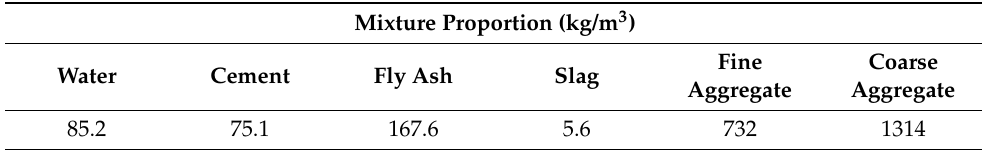
Figure 7. Simplified DuCOM calculation model for dam concrete. According to the DuCOM system and thematerial parameters from the design re- ports, the long-term properties of dam concrete were numerically analyzed. The mineral compositions of the cement, including C3A, C3S, C2S, C4AF, and Gypsum, were 15.50%, 54.76%, 14.16%, 5.47%, and 3.40% by mass, respectively. Because the mixture proportions of concrete varied during construction, average mixture proportions were applied for simulations to simplify the calculations, as shown in Table 3. Table 3. The average mixture proportions of dam concrete during